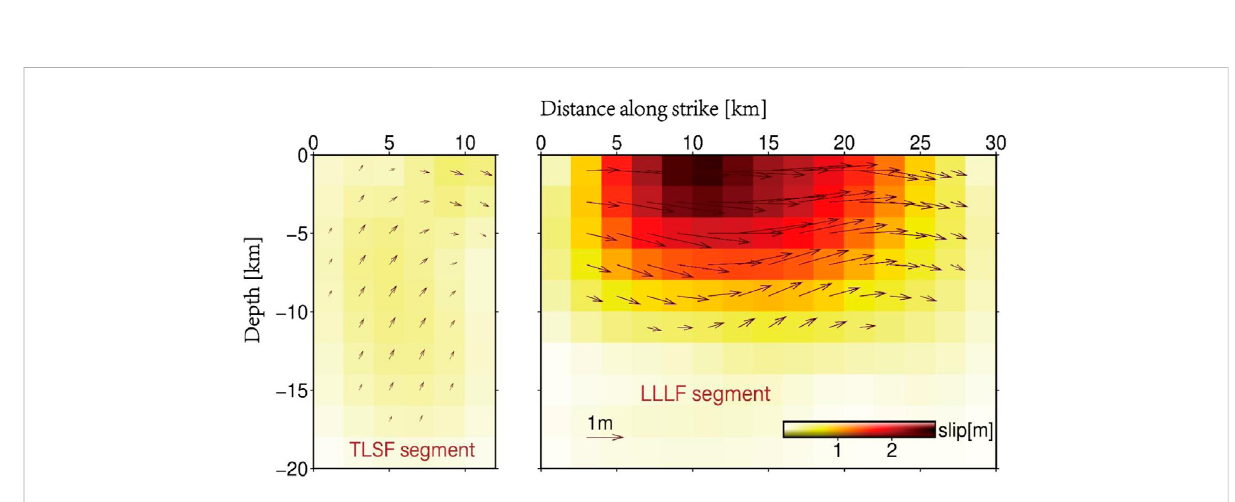
FIGURE 7 Coseismic slip distribution of the 2022 Mw6.7 Menyuan earthquake constrained by the atmospheric-corrected InSAR data.